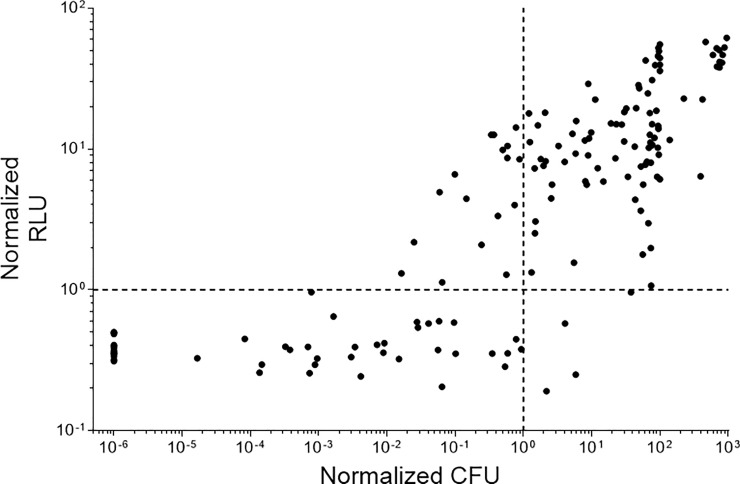
The reliability of luciferase as a marker for viability in non-replicating M. tuberculosis.Duplicate assay plates were incubated at 37°C for 7 days. RLU was measured from one set of plates using a Synergy2 plate reader. CFUs were measured from selected wells (n = 156). For CFUs, data were normalized to a 2-log reduction from the positive control (DMSO). For RLUs, data were normalized to the threshold level (defined as 3X background from the medium only wells). The dashed lines represent either a 2-log reduction in CFUs or the threshold value for RLUs. The upper left quadrant contains false negatives (11%) and the lower right quadrant contains false positives (2.6%).